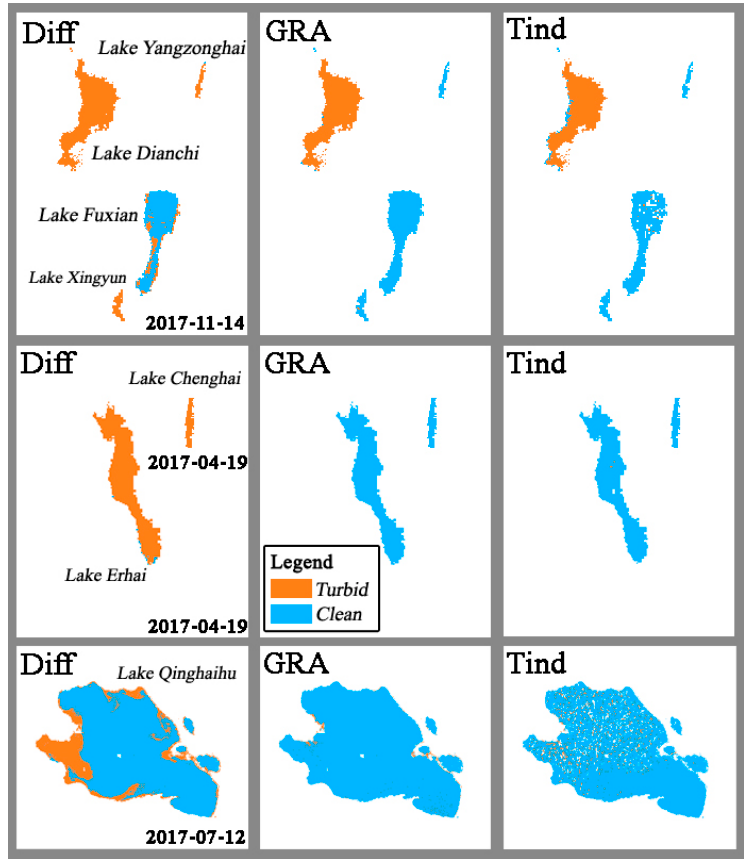
Figure 14. The results of water turbidity classification of Lake Dianchi, Lake Yangzonghai, Lake Fuxian, Lake Xingyun, Lake Erhai, and Lake Chenghai, which are all plateau lakes in Southwestern China, and Lake Qinghai is located on the Qinghai-Tibet Plateau. Blue and yellow represent clean and turbid waters, respectively.